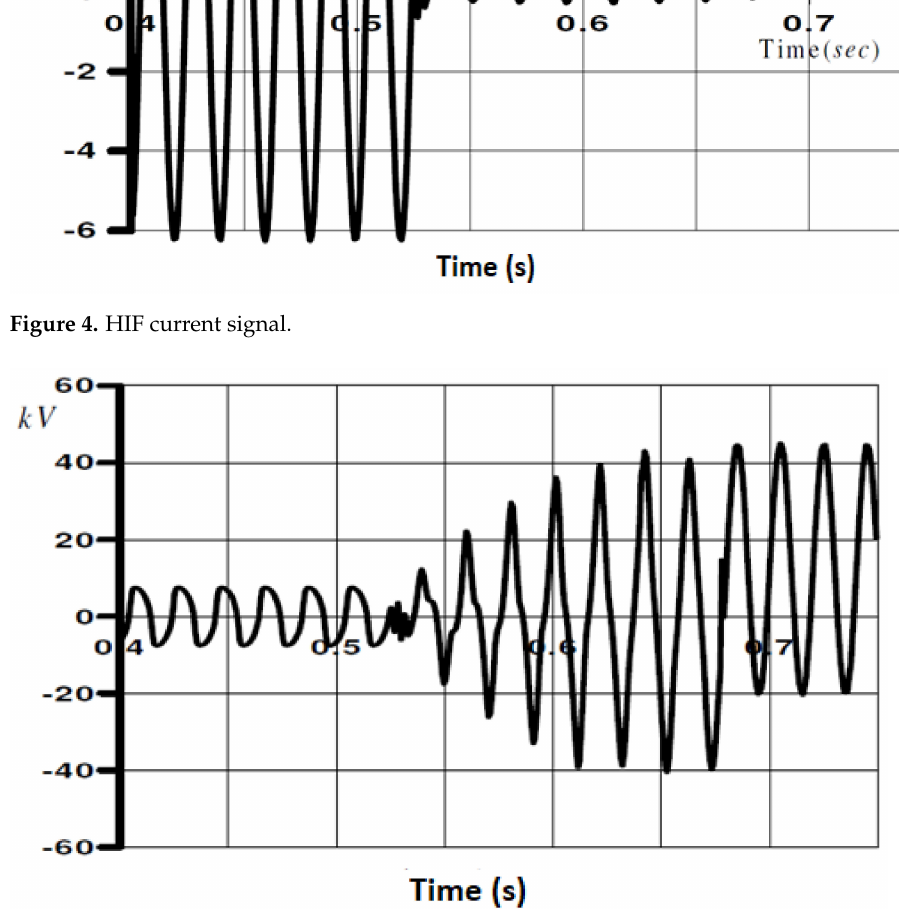
Figure 5. HIF arc